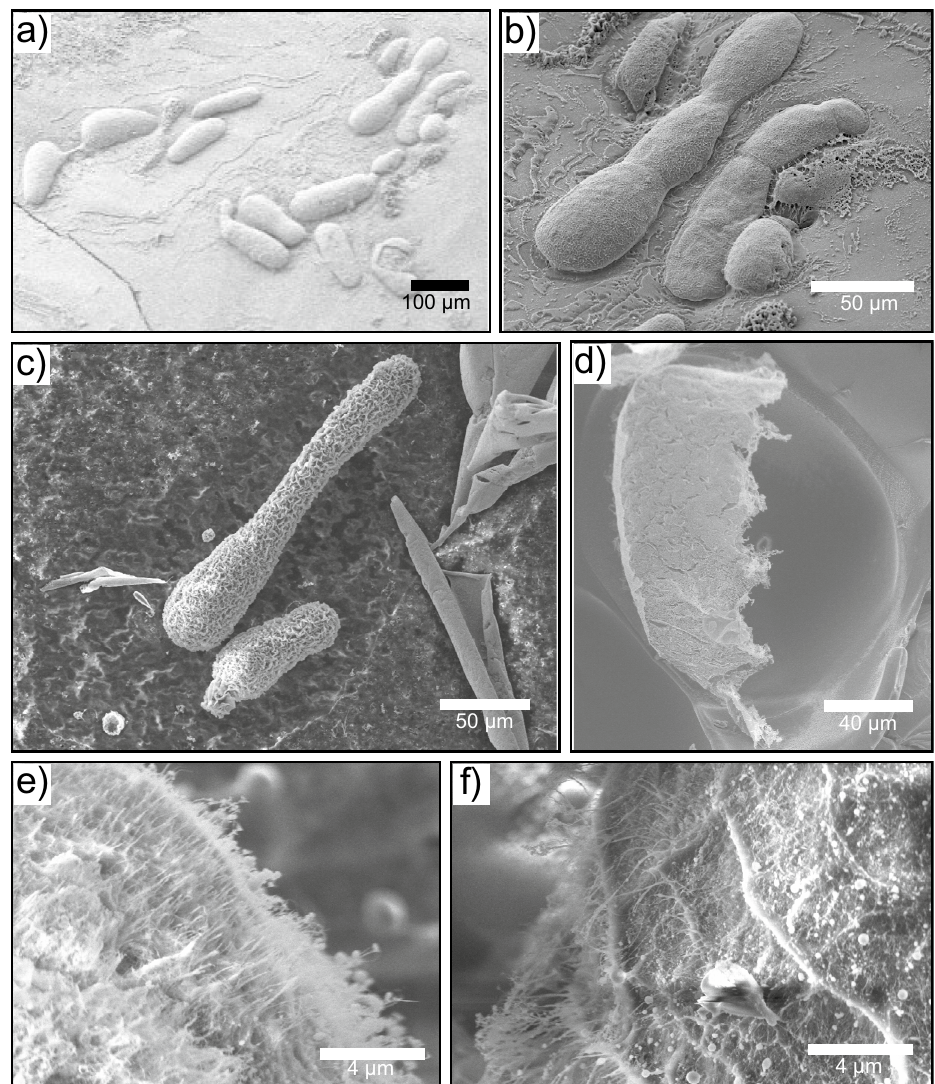
Figure 3. (a–c) Cryo-SEM micrographs of tubular/asymmetric microgels. (d) Micrograph of a fractured microgel which shows that the surface has aggregated whereas the core remains liquid. (e,f) High magnification cryo-SEM micrographs of the microgel surface. A dense fibrillar network is clearly